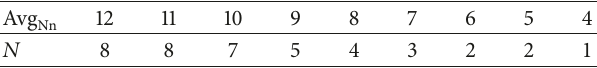
Table 2: Best network coding scheme selection as a function of average number of